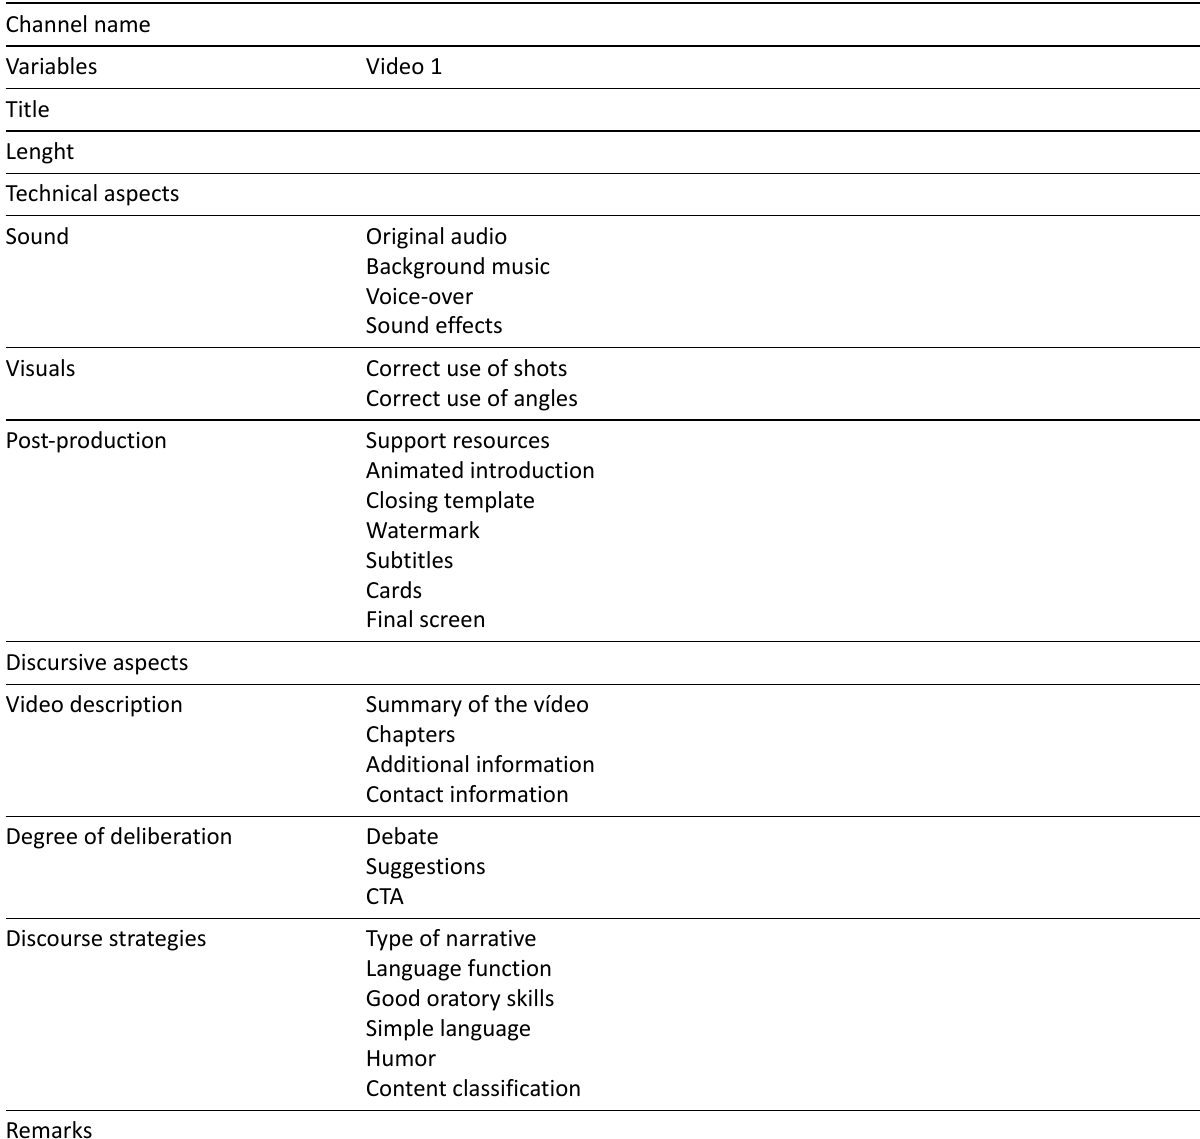
Table 2. Categories of analysis for the